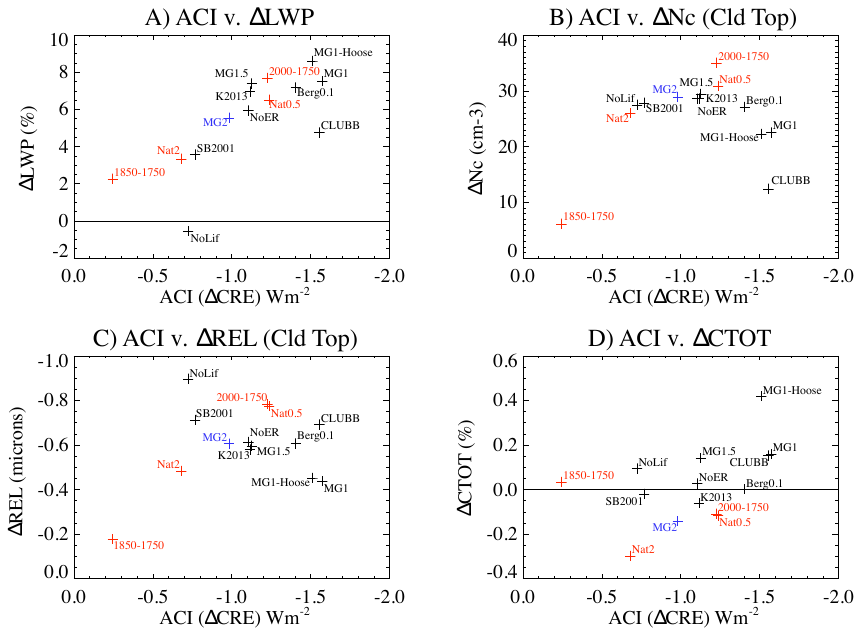
Figure 7. ACI (change in CRE, Wm − 2 ) vs. (a) percent change in LWP, (b) change in cloud-top drop number concentration ( (cid:49)N c , cm − 3 ), (c) change in cloud-top effective radius ( (cid:49) REL, m − 6 or microns) and (d) change in total cloud coverage (CTOT, %) for different sensitivity tests. Red colors are tests of different emissions, blue is the base MG2 case and black is the other sensitivity